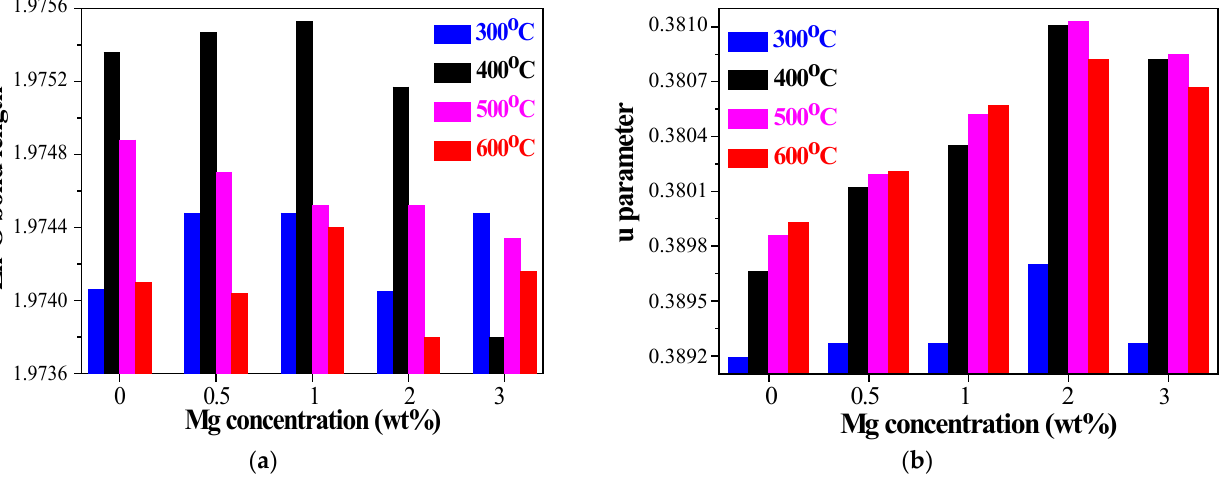
Figure 7. Determined values of ( a ) Zn–O bond length and ( b ) u parameter, depending on magnesium concentration of 300–600 °C annealed ZnO and ZnO:Mg films.